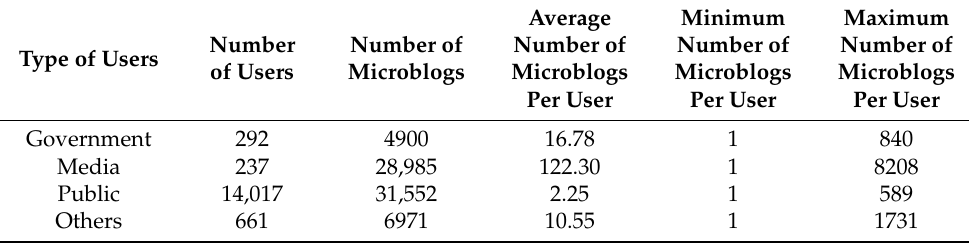
Table 2. Descriptive statistics of social media